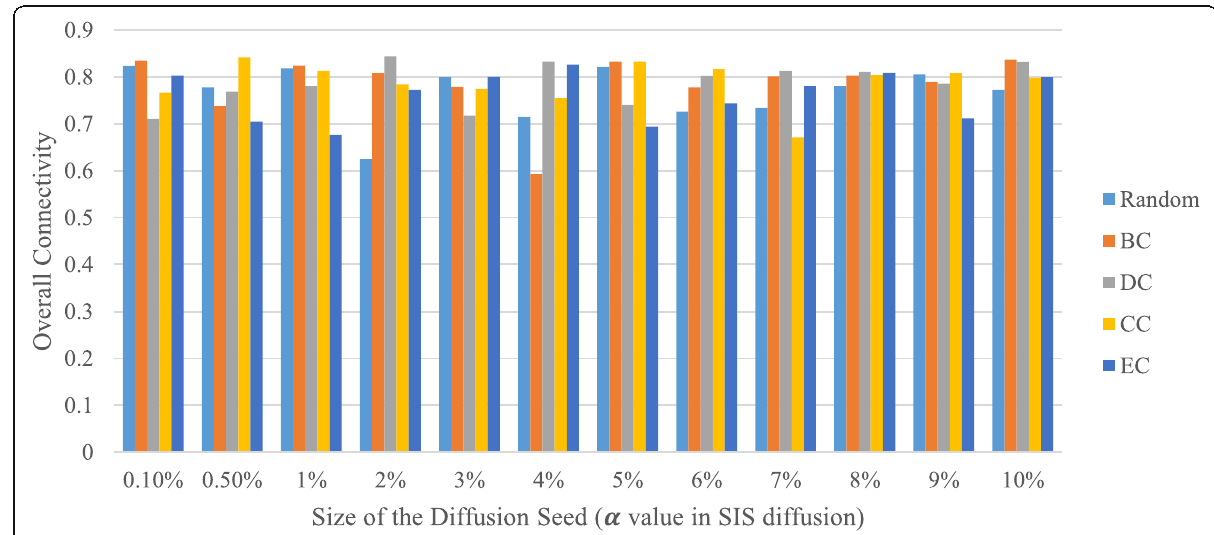
Fig. 9 Average Network Connectivity under different Diffusion